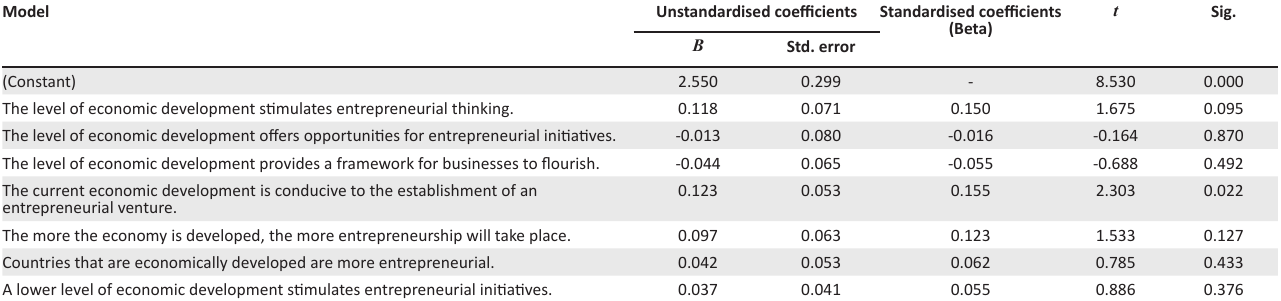
TABLE 7: Regression between economic development and entrepreneurial intentions. Model